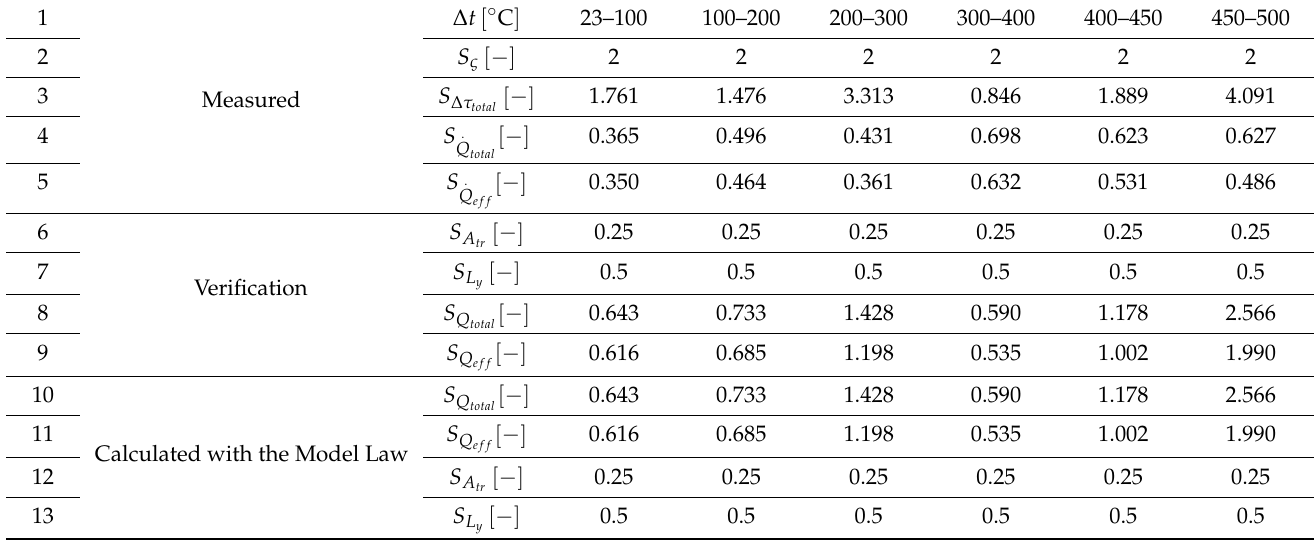
Table A12. The 1:4/1:2 painted